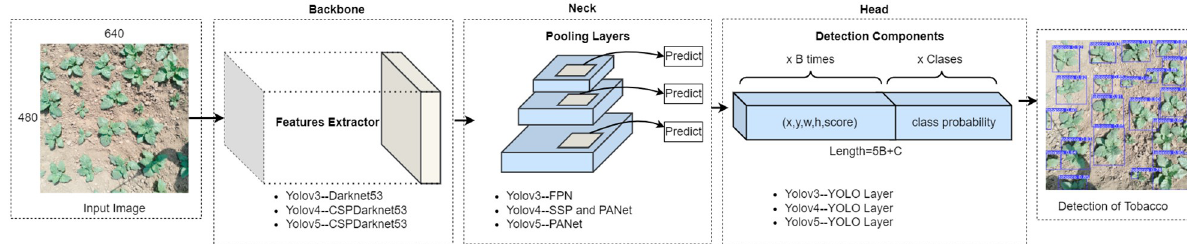
Fig 2. Architecture of YOLO-based object detection